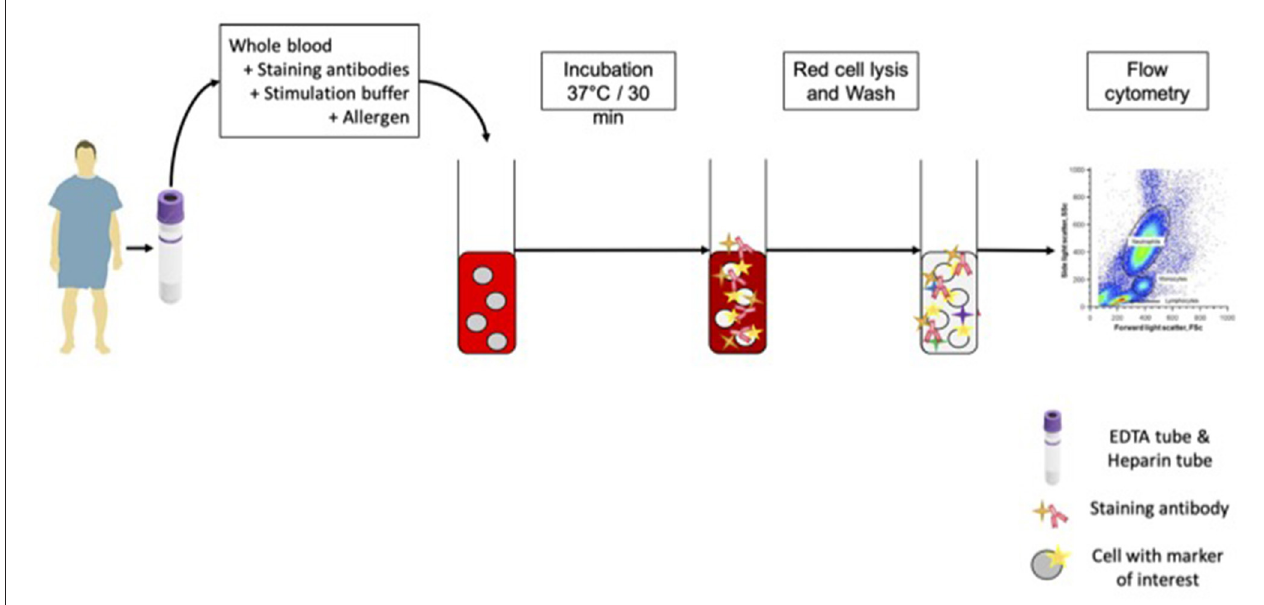
FIGURE 1 | BAT protocol. For each patient in the study, we sampled 1 EDTA tube for BAT. The whole blood was mixed with staining antibodies, stimulation buffer and allergen or controls. After incubation at 37 ◦ C, red cell lysis and wash, cells were analyzed on FACS.